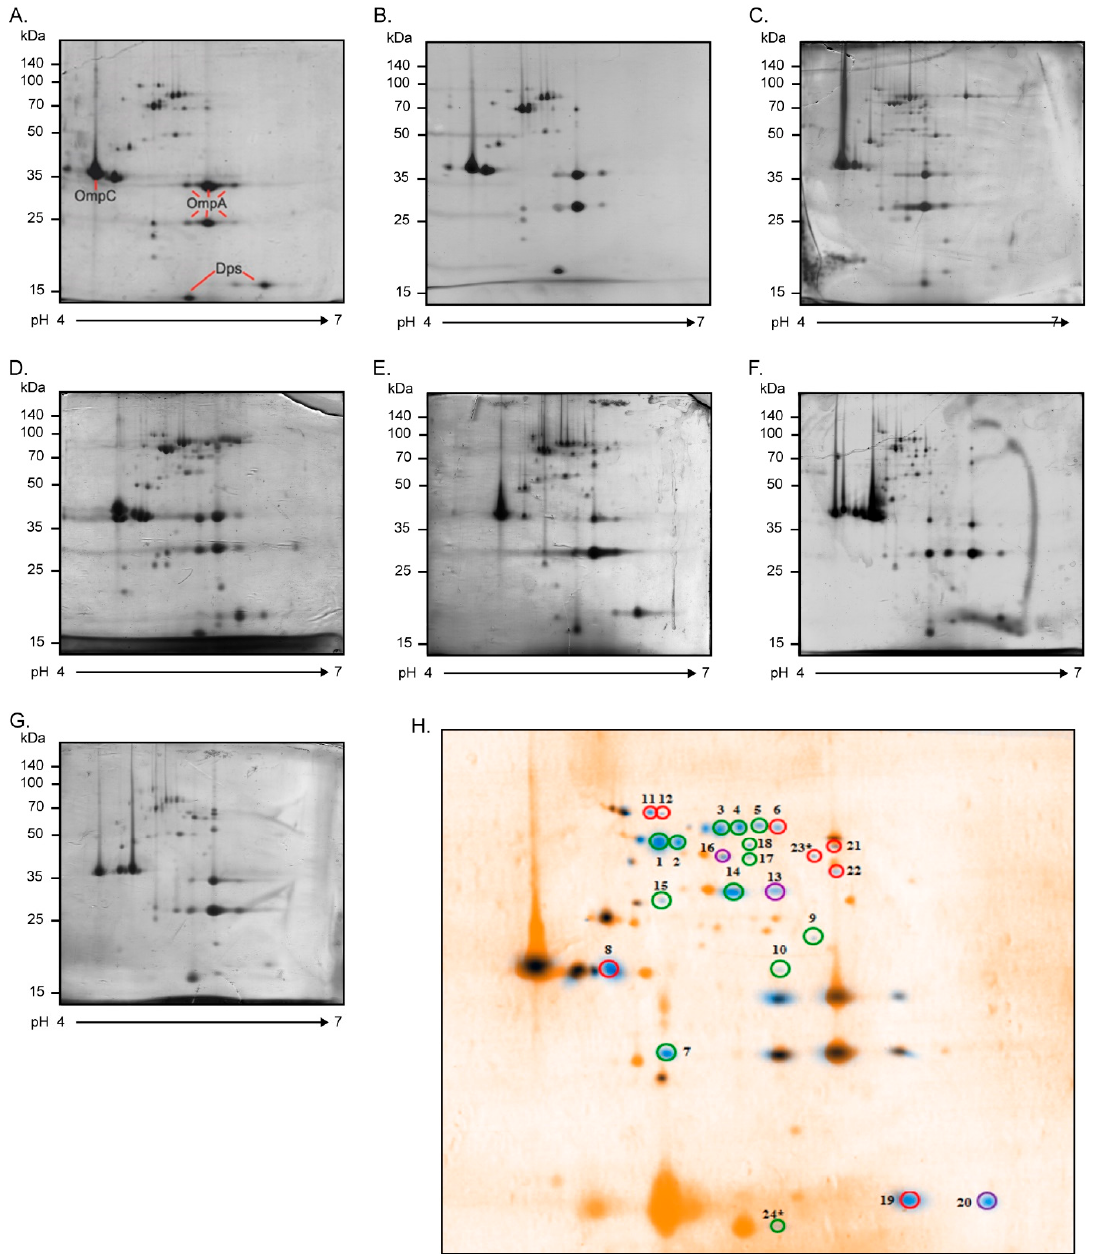
Figure 2. OMP profiles of AIEC strains. Two-dimensional polyacrylamide gel electrophoresis (2D- PAGE) OMP profiles of the AIEC strains grown in DMEM (2% bile salts) at 37 °C overnight: ( A ) 4I01, ( B ) 4C01, ( C ) 5I01, ( D ) 6I09, ( E ) 9C01, ( F ) 10I01, and ( G ) 18I08. Twelve percent polyacrylamide gels (13 cm; pH range: 4–7) were stained with Coomassie blue G-250. The scale bars on the left indi- cate molecular weights in kDa. Proteins with a well-known 2D-PAGE pattern are indicated (OmpA, OmpC, and Dps). ( H ) A representative AIEC OMP profile (blue spots) involving all the proteins present in at least 70% of the strains was superimposed on the commensal E. coli HS protein profile (orange spots). This analysis was performed using BioNumerics 2D software (v6.6). A total of 24 protein spots expressed differentially were selected and identified with MALDI-TOF/TOF mass spectrometry. These spots were absent in the HS OMP profile and highly frequent in the AIEC OMP profiles, as follows: 7/7 (100%, enclosed in green), 6/7 (86%, enclosed in purple), and 5/7 (71%, en- closed in red). * Spots 23 and 24 had no significant e-values in the MALDI-TOF/TOF analysis and were therefore discarded.